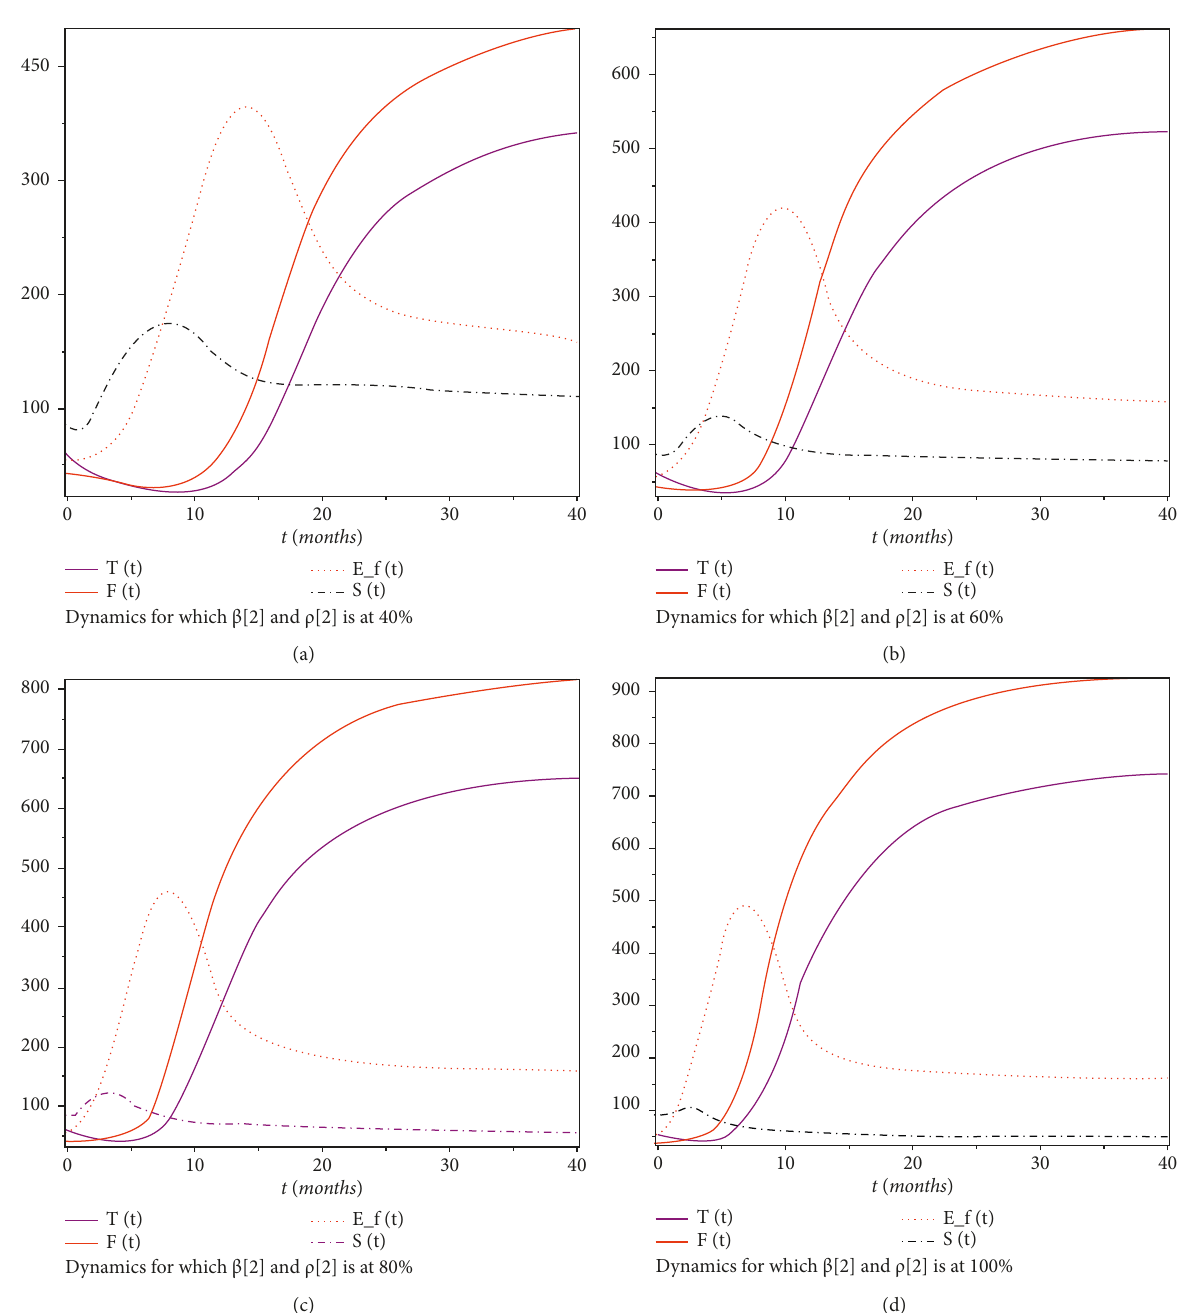
) and successful recruitment into 2